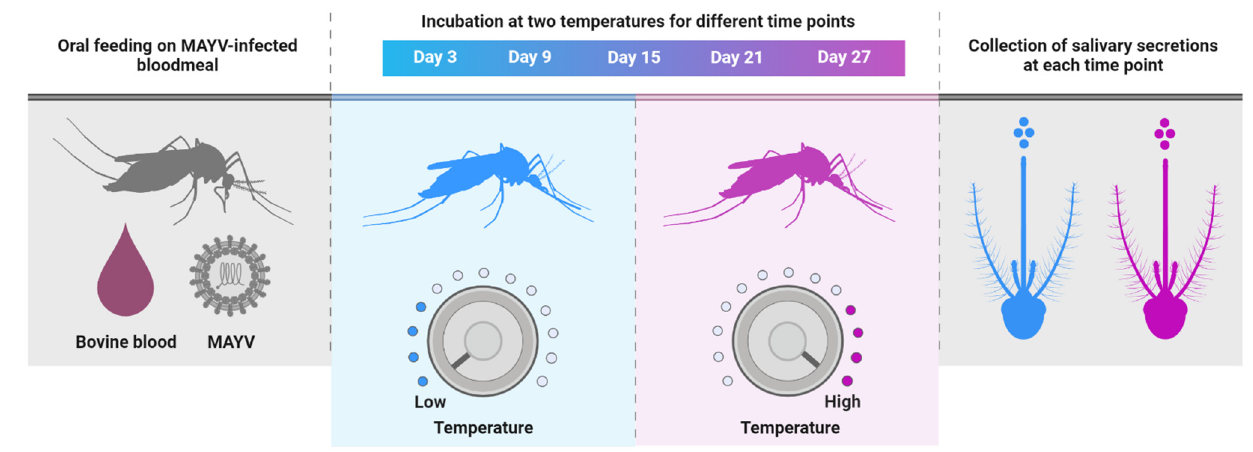
Figure 2. Schematic diagram of the experimental design.